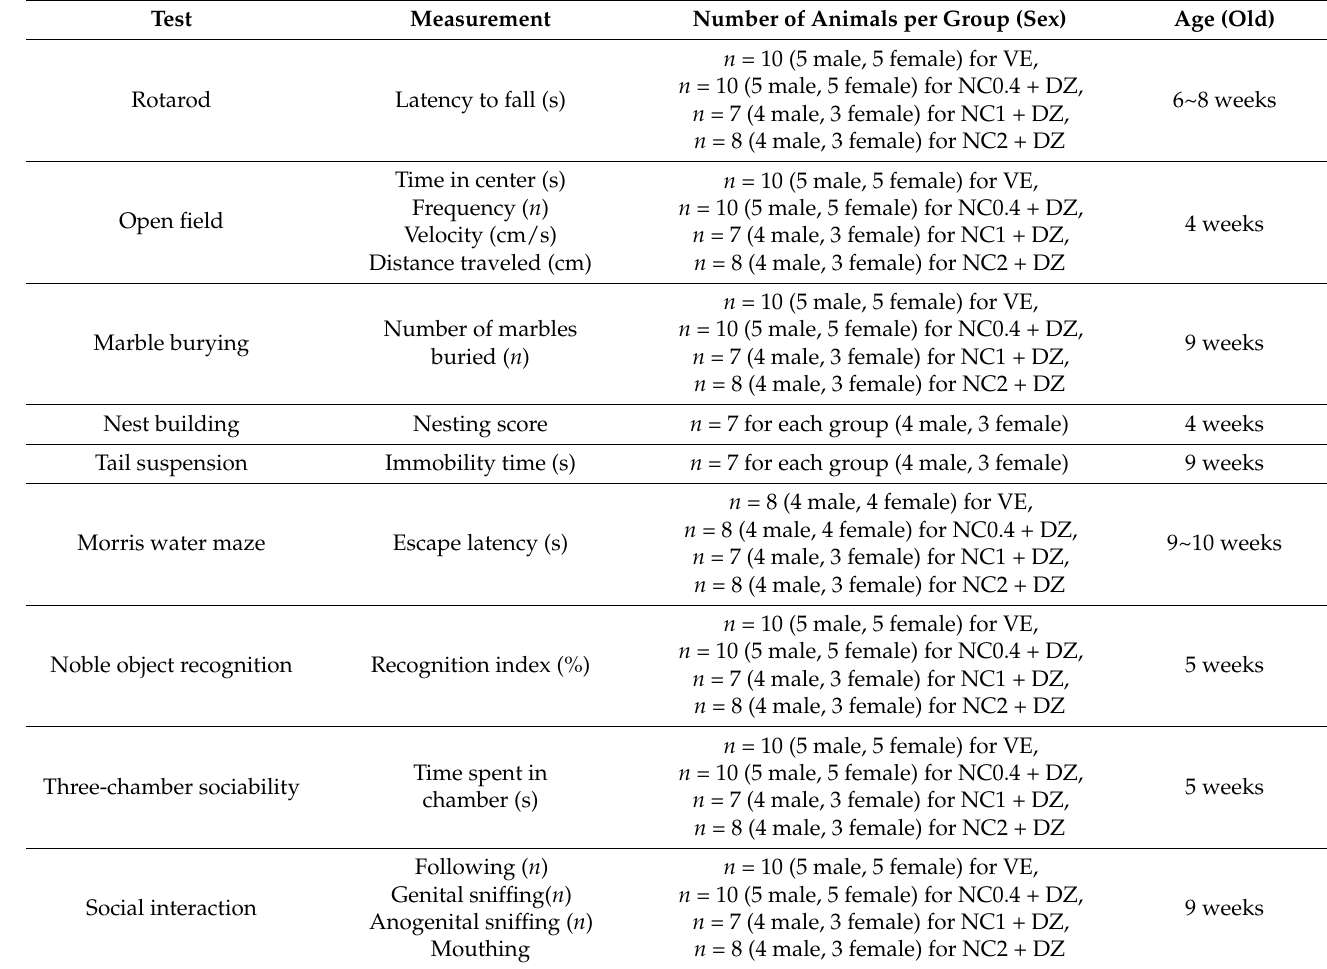
Table 1. Animal data for behavior